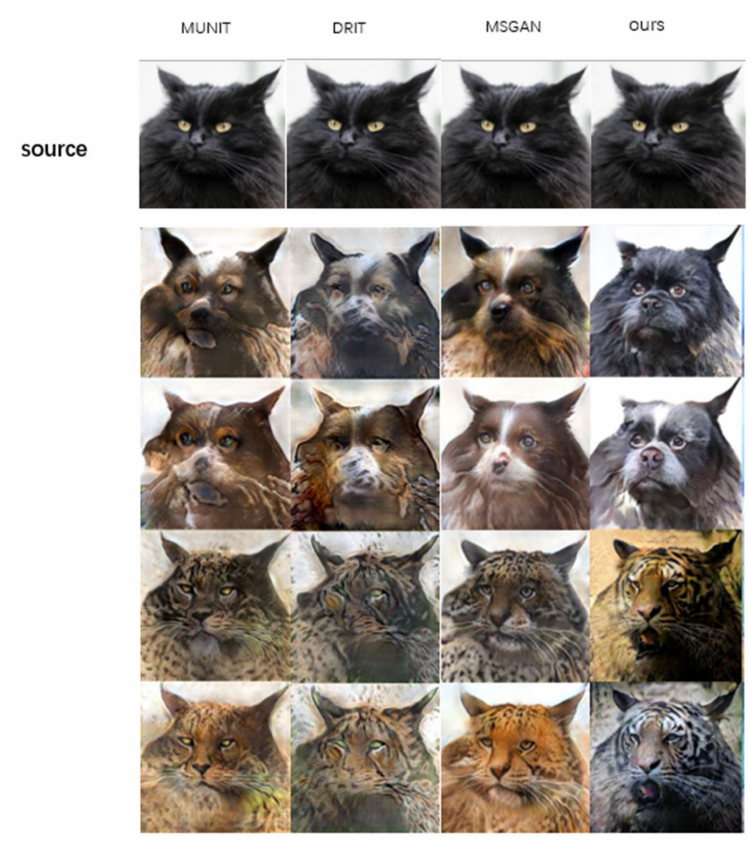
Figure 9. Using random noise to guide generation of images in